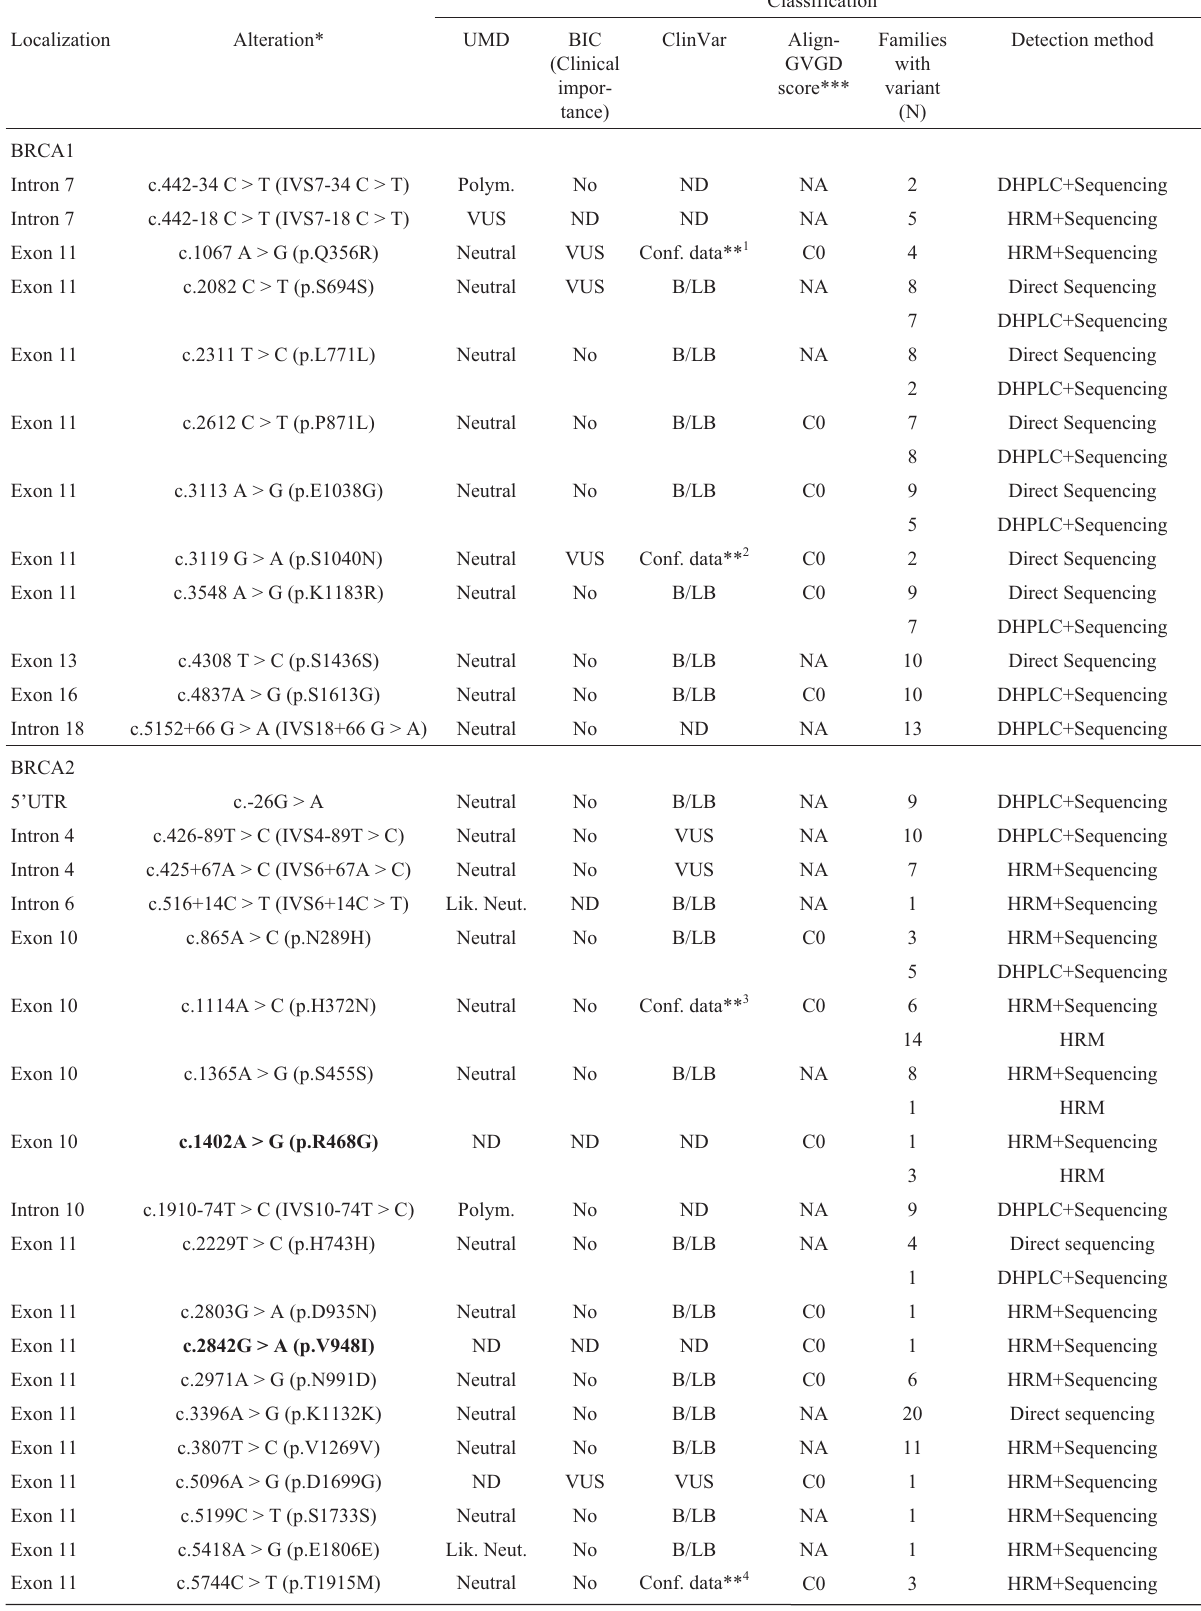
Table 3 - BRCA1 and BRCA2 sequence variants identified in the 18 families fulfilling HBOC syndrome